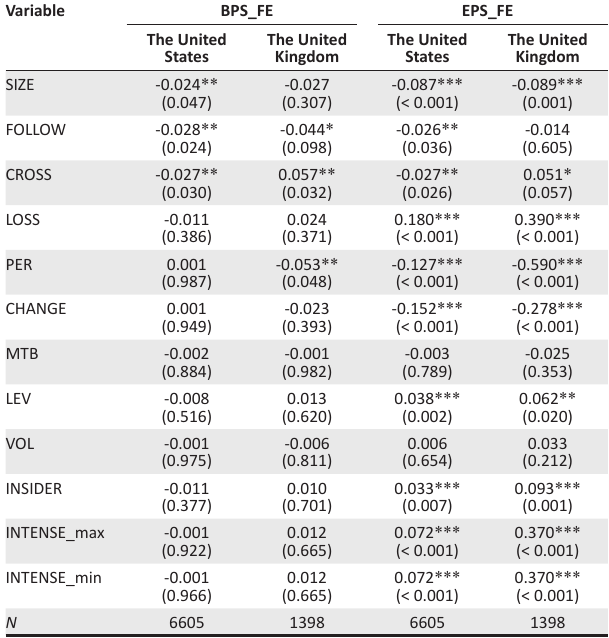
TABLE 2: Univariate investigations.